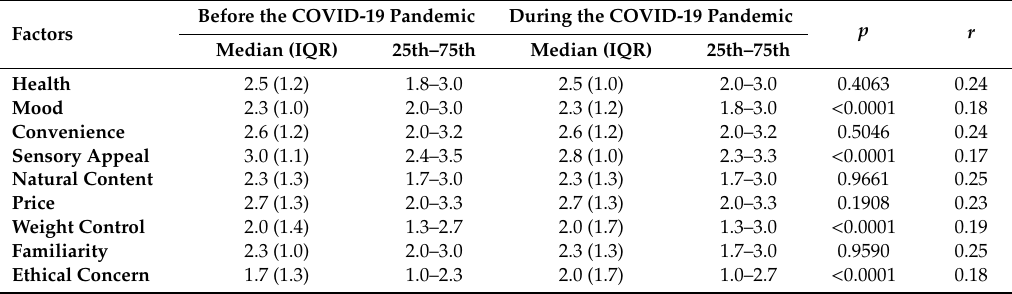
Table 7. The factors influencing food choice based on the applied Food Choice Questionnaire (FCQ) for the period before and during the COVID-19 pandemic for the sample of male adolescents studied within the PLACE-19 Study ( n =